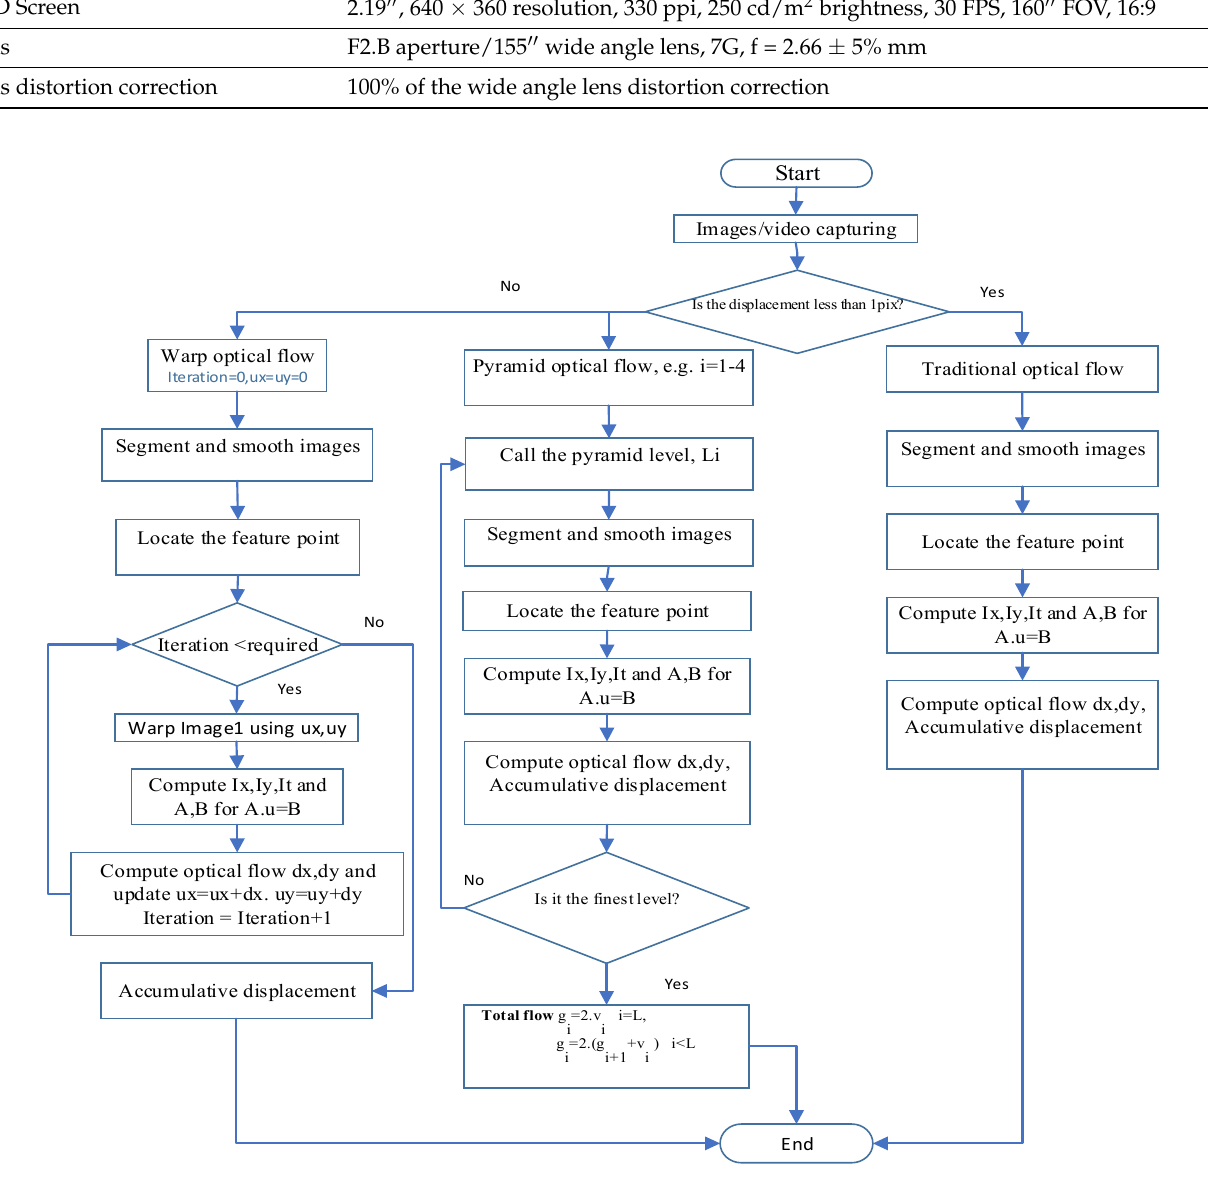
Figure 1. Flowchart of LK optical fl ow.